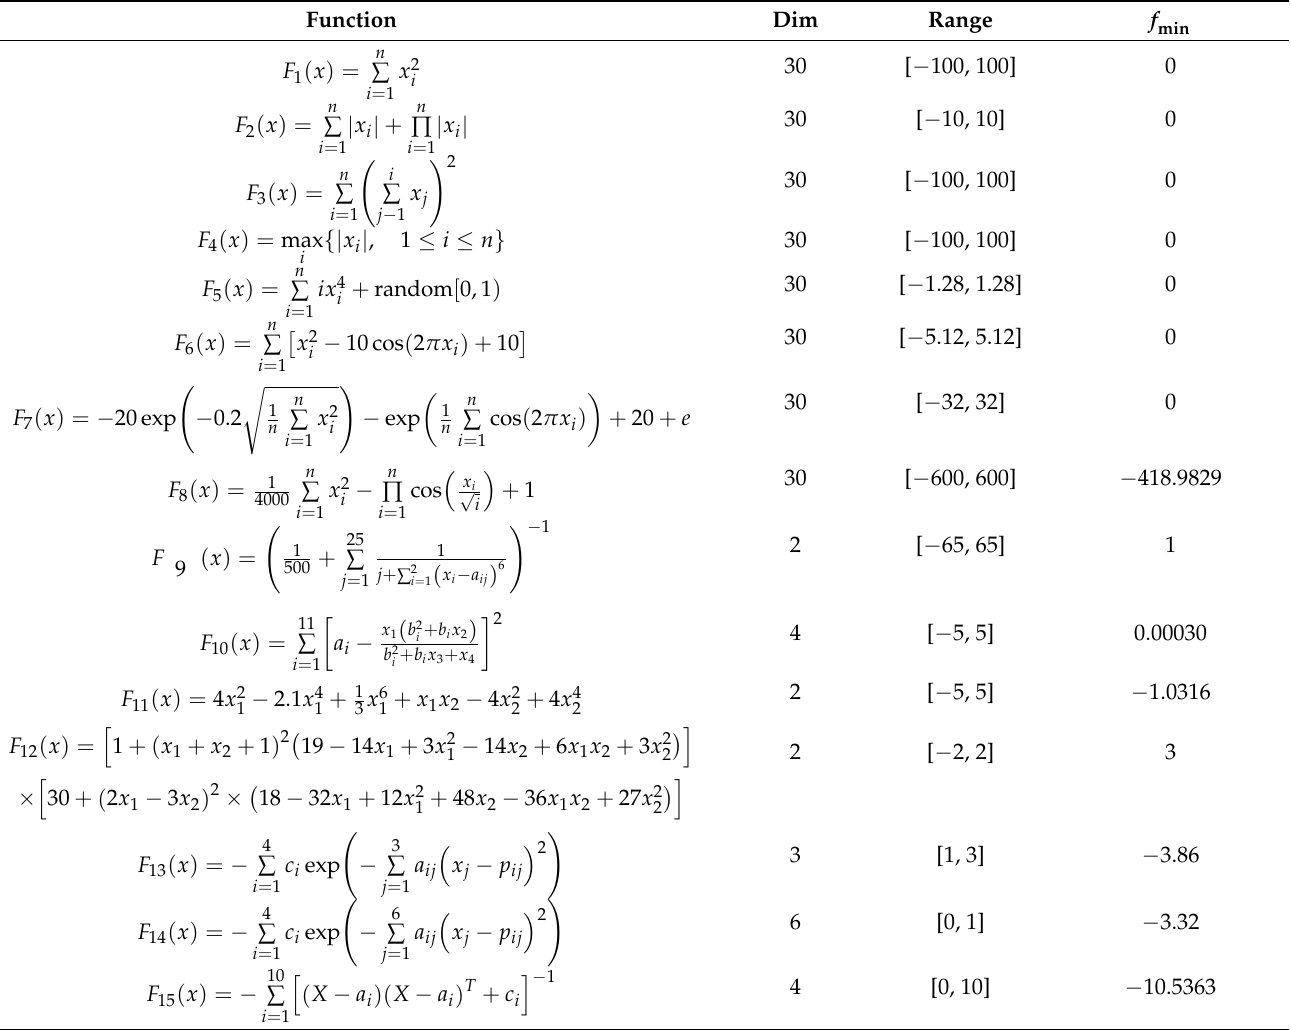
Table 1. Description of unimodal benchmark